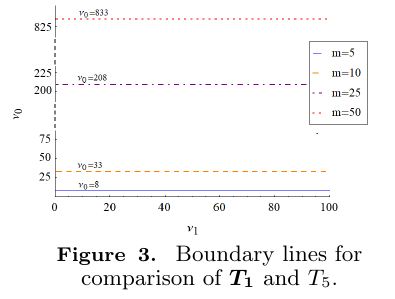
Figure 3. Boundary lines for comparison of T 1 and T 5 .